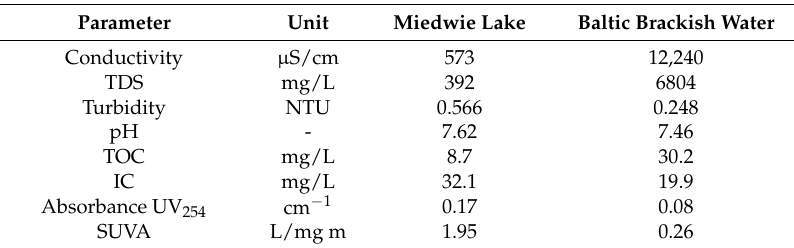
Table 3. The parameters of used natural waters.